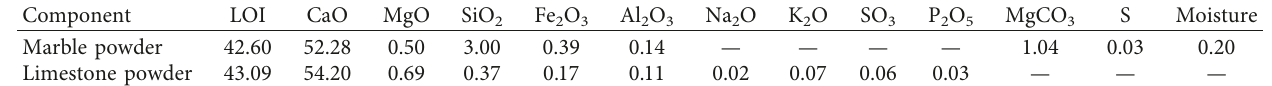
Table 1: Chemical compositions of marble powder and limestone powder (%).